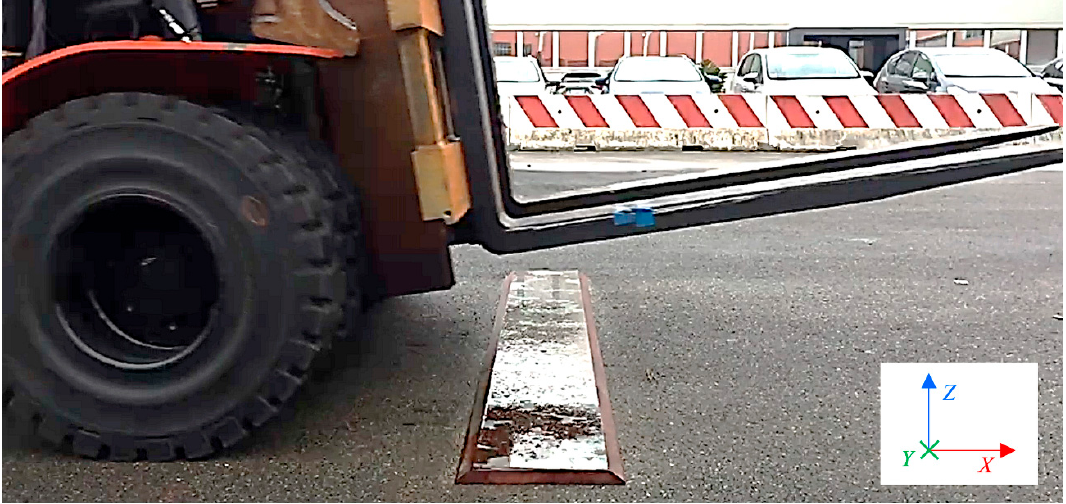
Figure 3. Close up of the steel obstacle just before being impacted during tests.